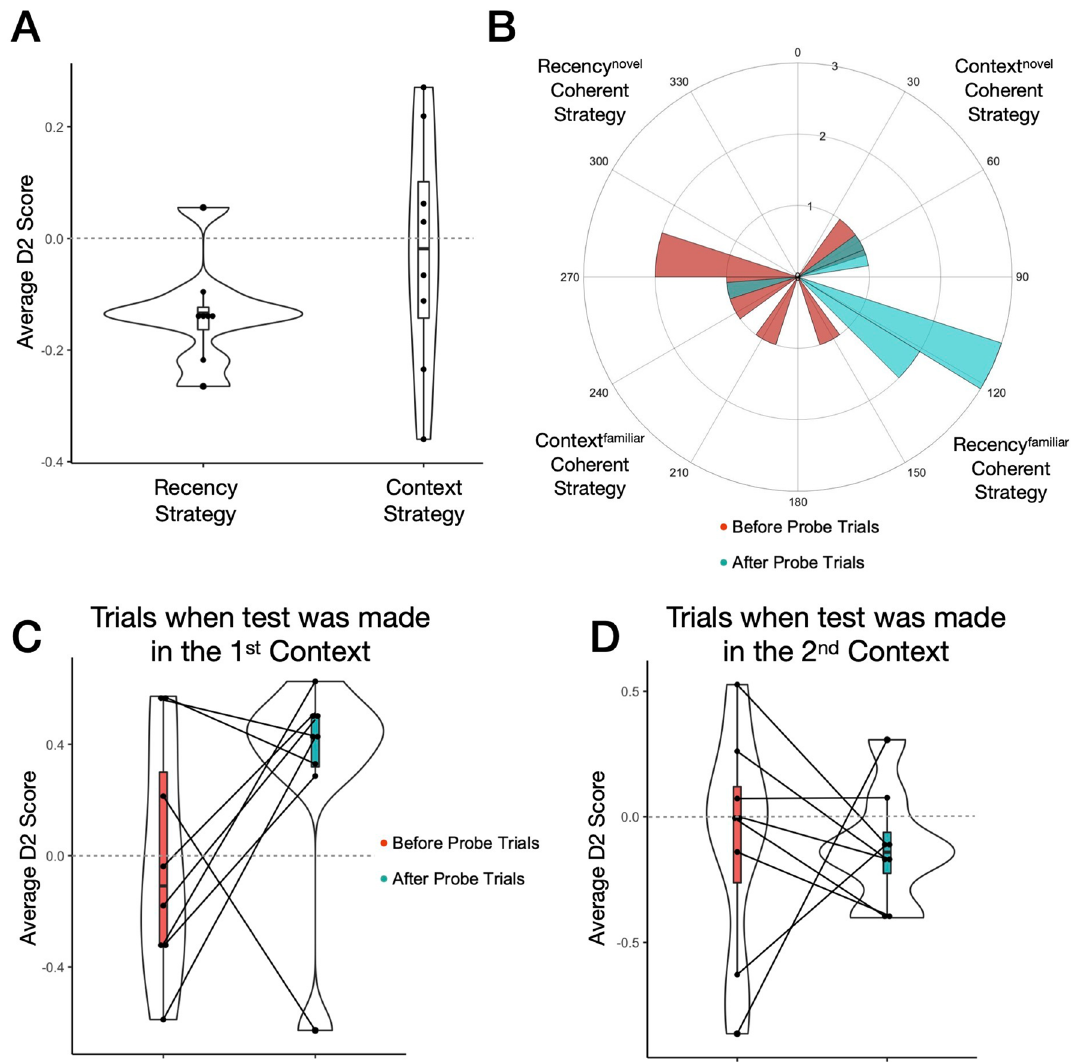
Figure 3. Rats change their behaviour to a familiarity driven recency-based strategy after probe trials. ( A ) Block 1 (probes excluded): The recency D2 (M = − 0.13, SD = 0.09) significantly differed from zero ( t (7) = − 4.03, p = 0.005, d = − 1.42, CI 95% − 2.41, − 0.39). The context D2 score (M = − 0.02, SD = 0.22) and side bias (M = − 0.04, SD = 0.17) did not differ from zero ( t (7) = − 0.31, p = 0.76, d = − 0.11; t (7) = − 0.72, p = 0.50, d = − 0.25; respectively). ( B ) Angular histogram before probe angles (M = − 109.4°, SD = 85.4°, n = 8), after probe angles (M = 106.0°, SD = 50.2°, n = 8), 20 bins of 18°. The before probe angles were uniformly distributed around the circle (Rayleigh-test: Z = 0.87, p = 0.43), but the after probe angles were not (Rayleigh-test: Z = 3.71, p = 0.02). This implies that there was significant directionality to the data after probe trials, in the theoretical direction for a coherent Recency familiar strategy (see Fig. 1F). Also, the before and after probe angles did not have a common mean direction (Watson–Williams F test: F 1,14 = 10.40, p = 0.006), suggesting a change in behaviour after experiencing probes in block 1. ( C ) Average before/after probes context D2 score from trials only when the test was made in the 1st context (before: M = − 0.01, SD = 0.43; after: M = 0.44, SD = 0.12). The before probes context D2 did not differ from chance ( t (7) = − 0.09, p = 0.93, d = − 0.03), however the after probes context D2 score did ( t (6) = 10.23, p < 0.001, d = 3.87, CI 95% 1.61, 6.11) and from the before D2 score ( t (6) = − 2.63, p = 0.04, d = − 0.99, CI 95% − 1.89, − 0.05). ( D ) Average before/after probes context D2 scores from trials only when test was made in the 2nd context (before: M = − 0.10, SD = 0.45; after: M = − 0.12, SD = 0.23). Both did not differ from zero ( t (7) = − 0.61, p = 0.56, d = − 0.22; t (7) = − 1.48, p = 0.18, d = − 0.52; respectively) nor from each other ( t (7) = 0.11, p = 0.92, d =